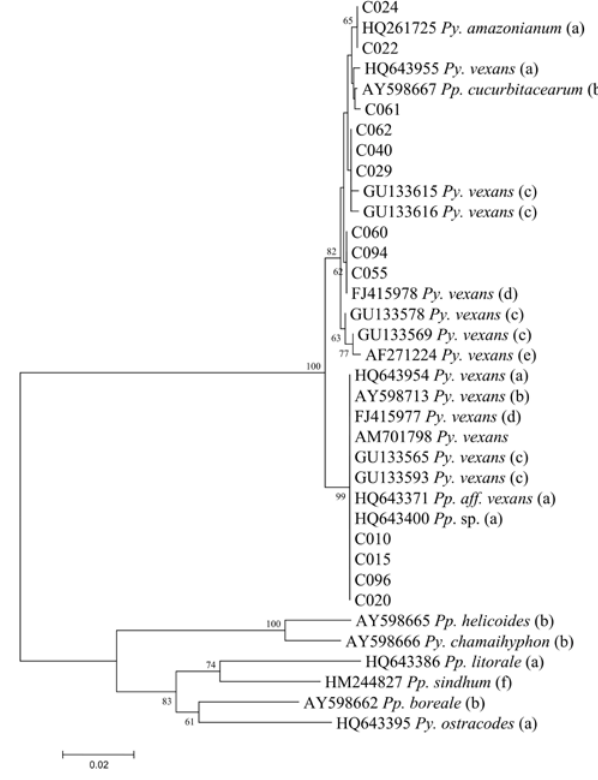
Figure 4. Phylogenetic tree of Phytopythium spp. that was constructed by the neighbour-joining method based on their rDNA-ITS sequences, showing the position of Phyto- pythium isolates that were obtained in this study within the Pp. vexans complex. Sequences from the studies by Ro- bideau et al. (2011) (a); Lévesque and De Cock (2004) (b); Spies et al. (2011a) (c); McLeod et al. (2009) (d); Cooke et al. (2000) (e); and Bala et al. (2010) (f). Numbers at the nodes of clusters represent bootstrap values that were generated from 1,000 pseudoreplicates (only values greater than 60% are